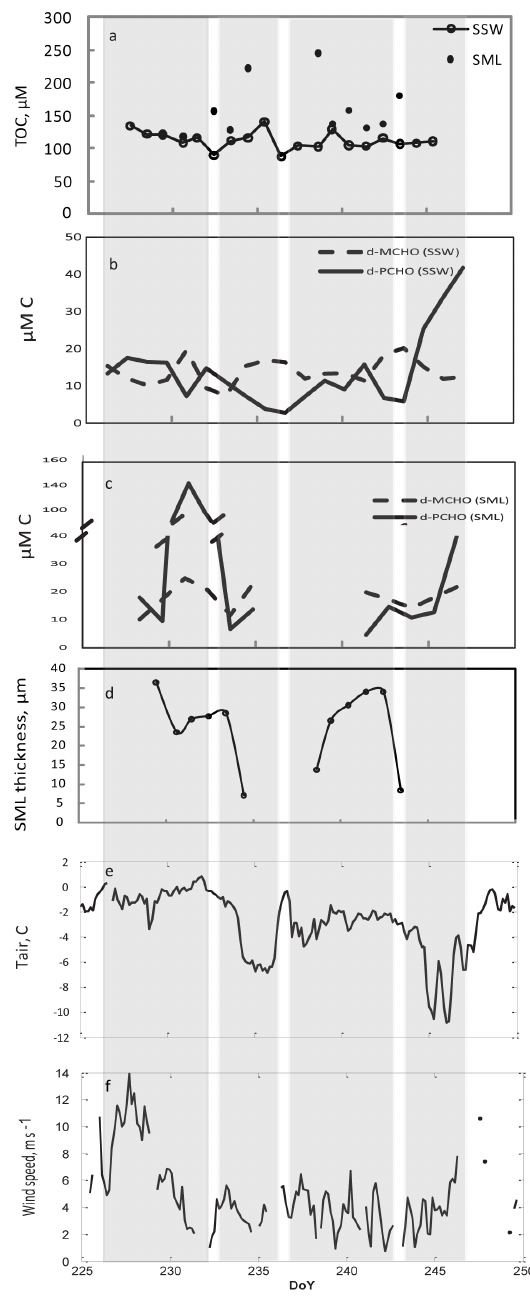
Fig. 2. Time series of total organic carbon (TOC) in surface microlayer (SML) and subsurface water (SSW) (a) , dissolved monosaccharides (d-MCHO) and dissolved polysaccharides (d- PCHO) in subsurface water (SSW) (b) , dissolved monosaccharides (d-MCHO) and dissolved polysaccharides (d-PCHO) in surface mi- crolayer (SML) (c) , SML thickness (d) and air temperature (e) . The four distinct periods based on the analyses by Sedlar et al. (2011) of the surface energy budget (see Sect. 3.1) are indicated by gray